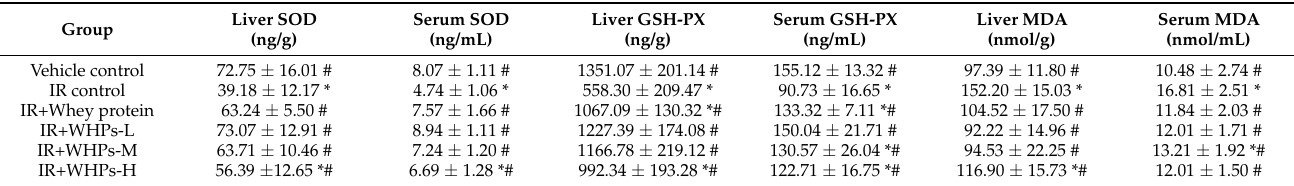
Table 8. Effect of WHPs on antioxidant defense systems at day 14 after radiation ( n = 12, x ± s).